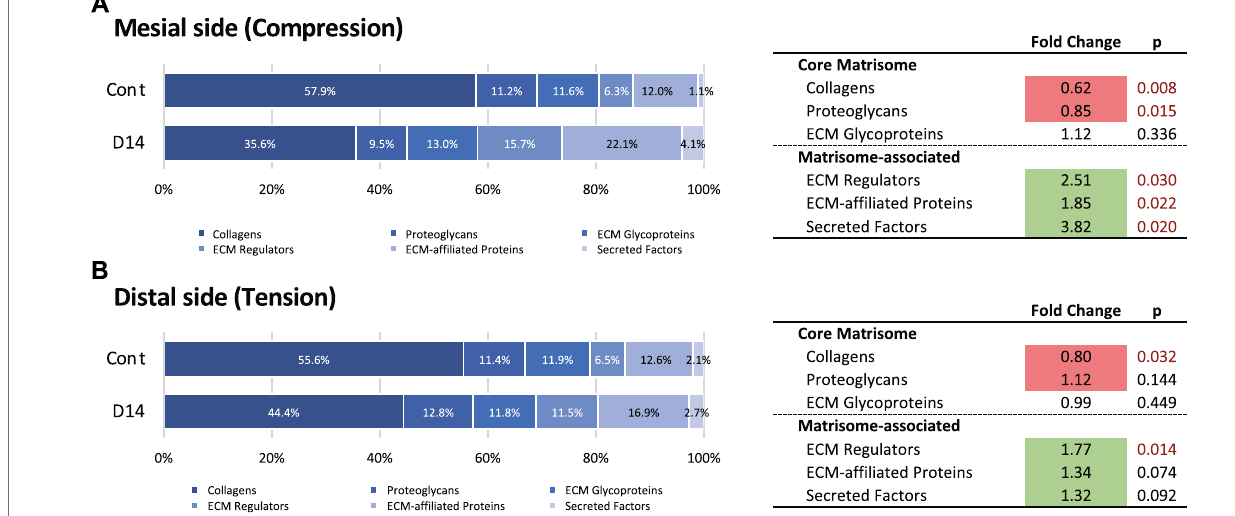
FIGURE 4 | Changes in the matrisome pro fi le at the mesial and distal sides of the PDL. Proportions of matrisome proteins and fold change of matrisome classes during OTM at mesial (A) and distal (B) sides ofthe PDL.Matrisomeclasses thatsigni fi cantlyincreasedand decreased inproportion onday 14(D14) compared withthe control (Cont) are highlighted in green and red, respectively.